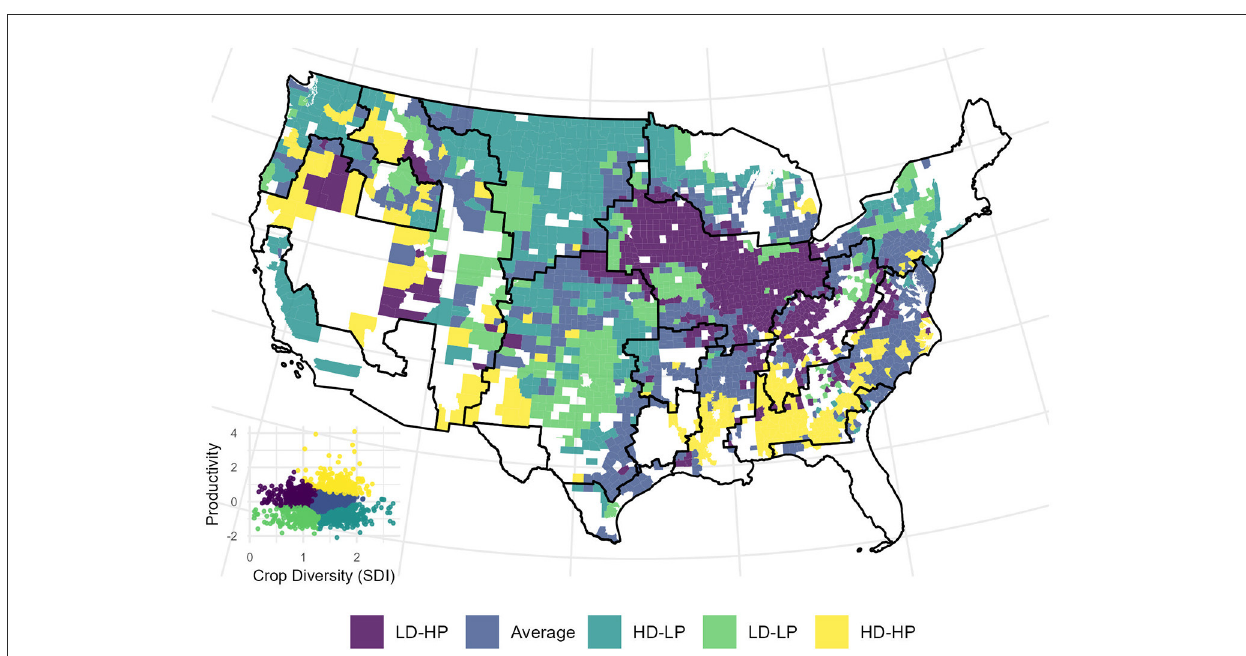
FIGURE1 Spatial distribution of county types specified using k-means cluster analysis and scatter plot (inset) of diversity and productivity for each class. Black borders indicate boundaries for USDA Farm Resource Regions (FRRs).